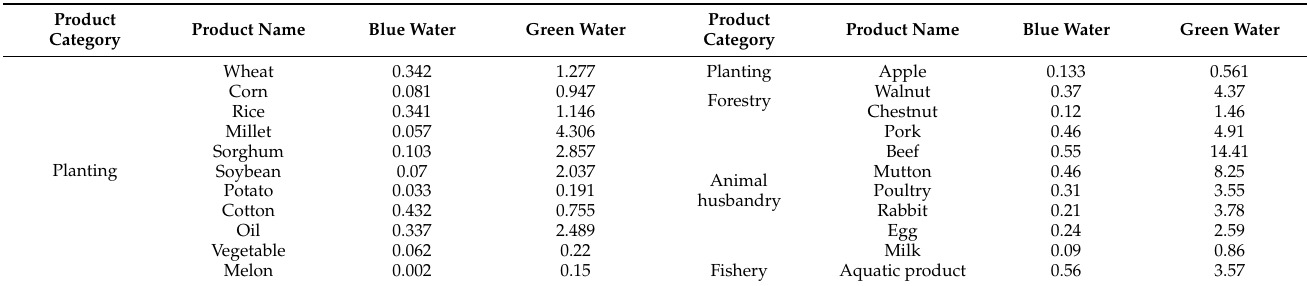
Table A1. Virtual water content of blue and green water per unit mass of planting, forestry, animal husbandry and fishery products (m 3